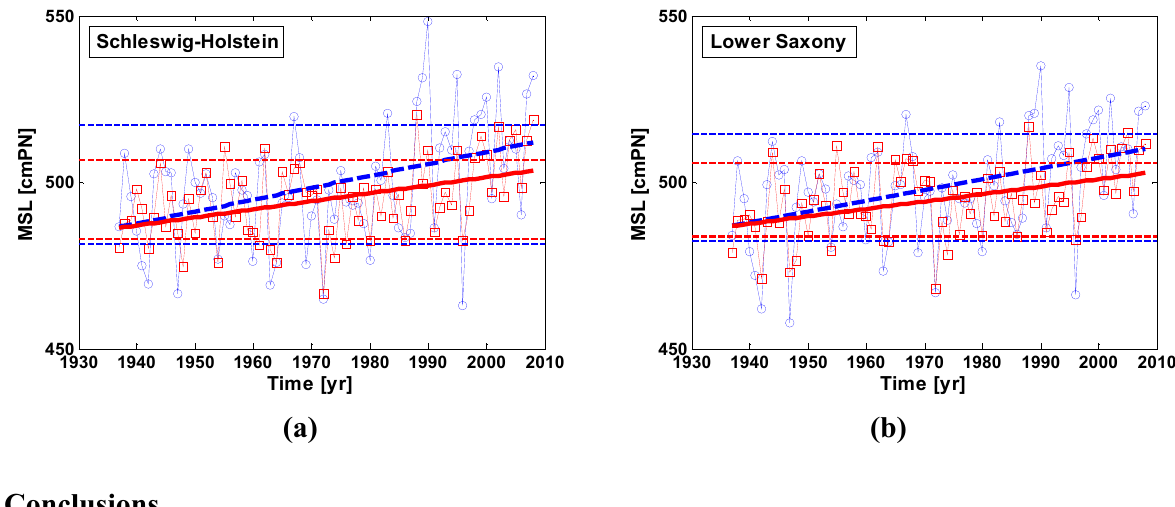
Figure 10. Influence of swNAO on swMSL (1937–2008) in the German Bight. The thin lines represent the swMSL data (blue = including swNAO; red = after removing swNAO). The thin dotted lines represent the standard deviations and the thick lines show the linear trends. ( a ) Schleswig-Holstein; ( b ) Lower